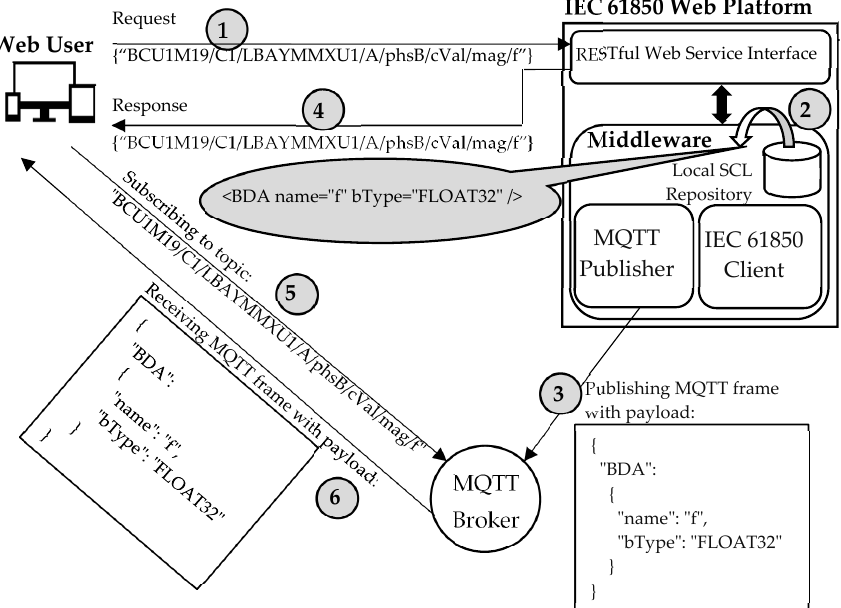
Figure 5. Example of the publication of the description of a Basic Data Attribute Type.